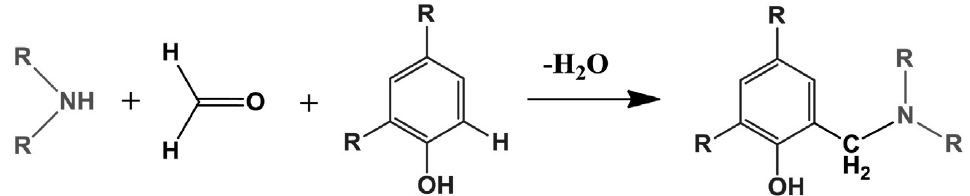
Figure 10. Mannich reaction mechanism utilized in the amination of lignins.